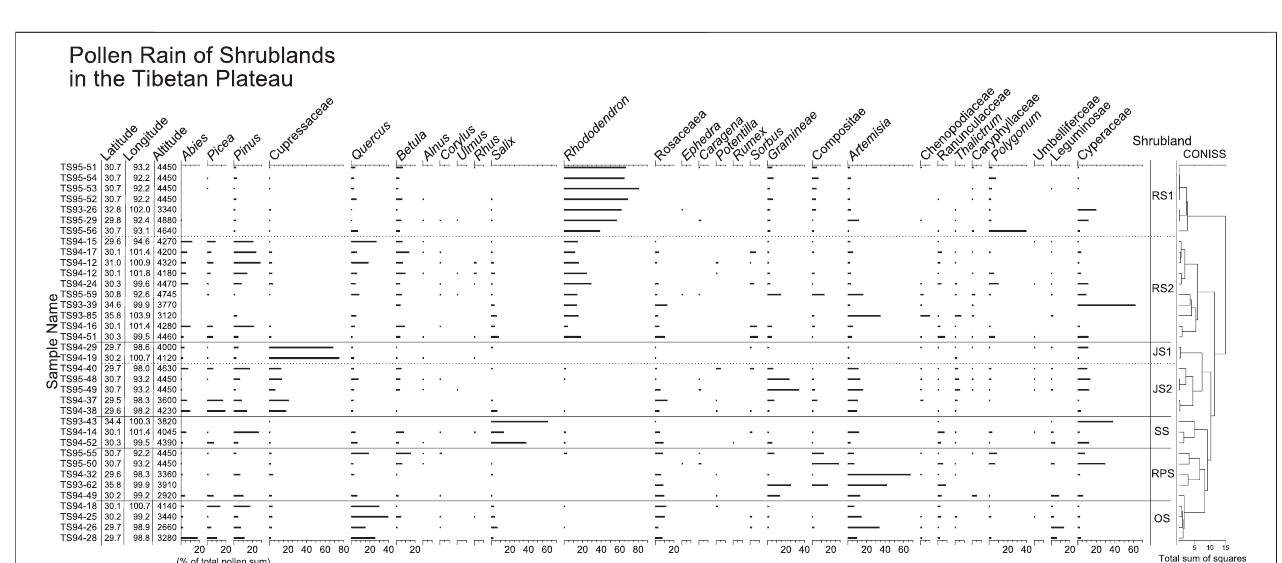
FIGURE4| PollenpercentagediagramforsurfacesamplesfromshrublandsintheTP.Shrublandtypesincluderhododendronshrub(RS),junipershrub(JS),willow shrub (WS), rosaceous shrub (RPS) and alpine oak shrub (OS).